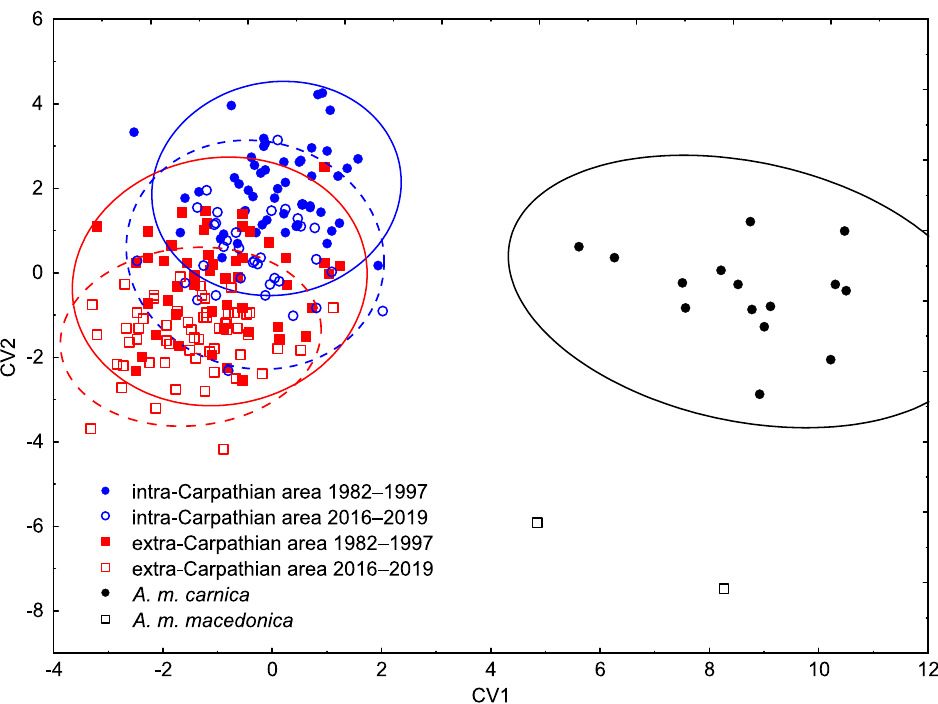
Figure 2. Discrimination between the areas and the reference samples, based on a canonical variate analysis of wing shape. Table 1. Squared Mahalanobis distances (lower triangle) between the investigated groups and the significance of pairwise comparisons (upper triangle). ***— p < 0.0001. Groups